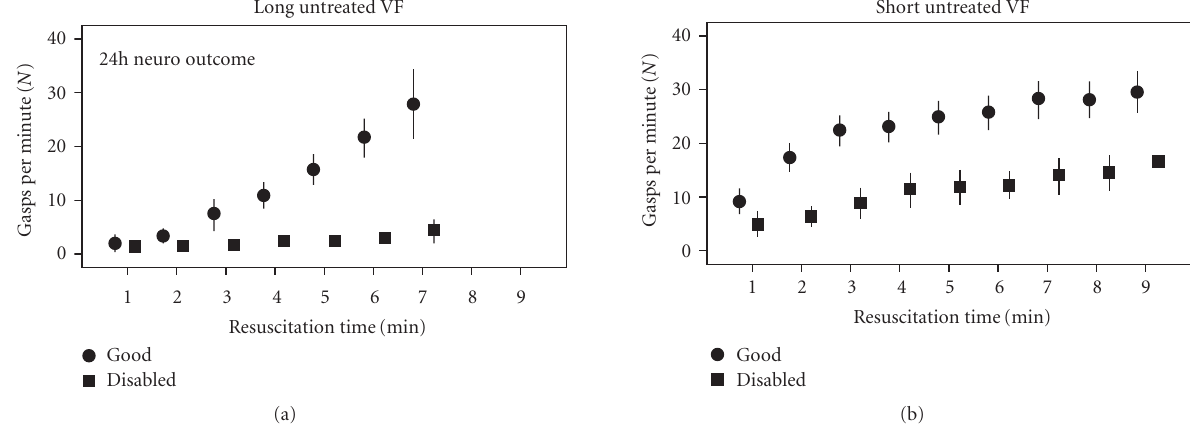
Figure 3: This figure presents the number of gasps per minute plotted against the duration of basic resuscitation e ff orts. (a) Long Untreated VF plots the number of gasps per minute (mean ± standard error) for each minute of basic resuscitation e ff orts irrespective of the applied resuscitation type in those with 5 to 6 minutes of untreated VF prior to the onset of basic resuscitation techniques. (b) Short Untreated VF plots the number of gasps per minute (mean ± standard error) for each minute of basic resuscitation e ff orts irrespective of the applied resuscitation type in those with 3 to 4 minutes of untreated VF prior to the onset of basic resuscitation techniques. Circles indicate those with good 24-hour neurological outcome, and the squares indicate those disabled (death or poor neurological outcomes). Standard error is indicated by the vertical lines.